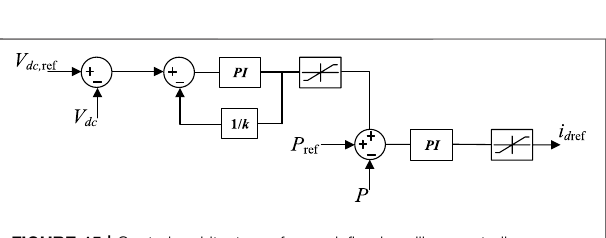
FIGURE 15 | Control architecture of user-de fi ned auxiliary